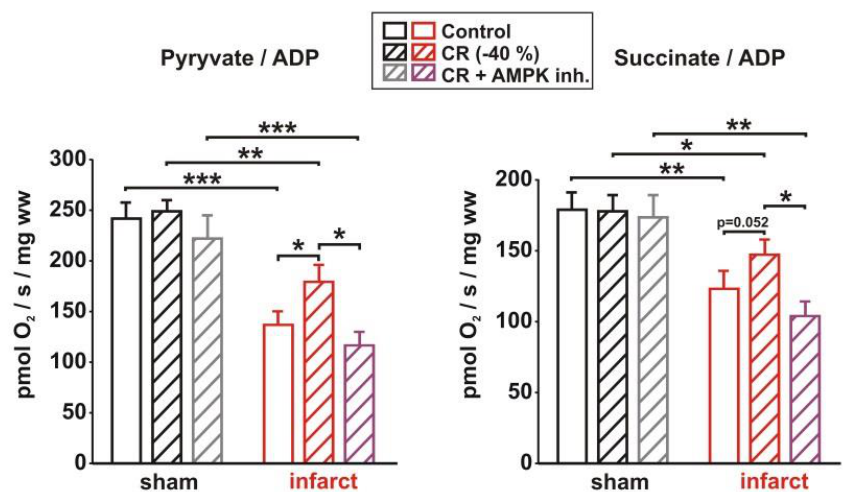
Figure 6. Effect of 8 weeks CR and 2 weeks of AMPK inhibition on mitochondrial respiration. Active rates of respiration (state 3) were measured in saponin-skinned cardiac fibers in the presence of 5 mM ADP and either 10 mM pyruvate + 2 mM malate or 10 mM succinate in the presence of 5 µ M rotenone in the LV of sham or infarct rats, following 8 weeks of control or CR diets and AMPK inhibition. All data are mean ± SEM. n = 5 animals per group, *: p < 0.05; **: p < 0.01; ***: p < 0.001.